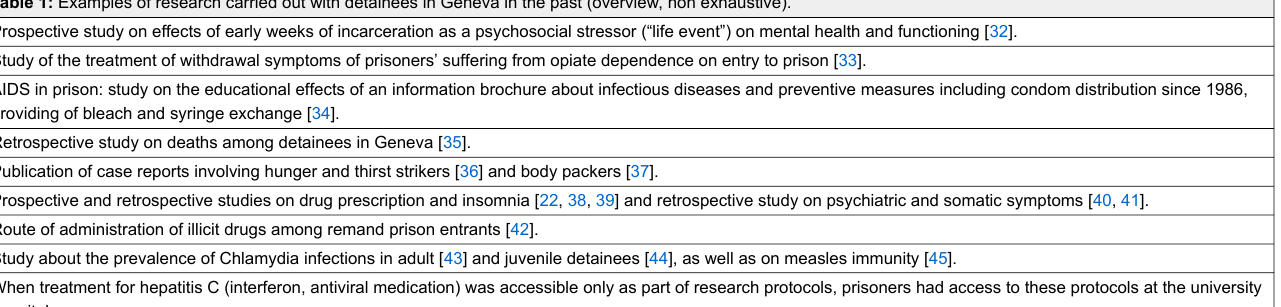
Table 1: Examples of research carried out with detainees in Geneva in the past (overview, non exhaustive). Prospective study on effects of early weeks of incarceration as a psychosocial stressor (“life event”) on mental health and functioning [32]. Study of the treatment of withdrawal symptoms of prisoners’ suffering from opiate dependence on entry to prison [33]. AIDS in prison: study on the educational effects of an information brochure about infectious diseases and preventive measures including condom distribution since 1986, providing of bleach and syringe exchange [34]. Retrospective study on deaths among detainees in Geneva